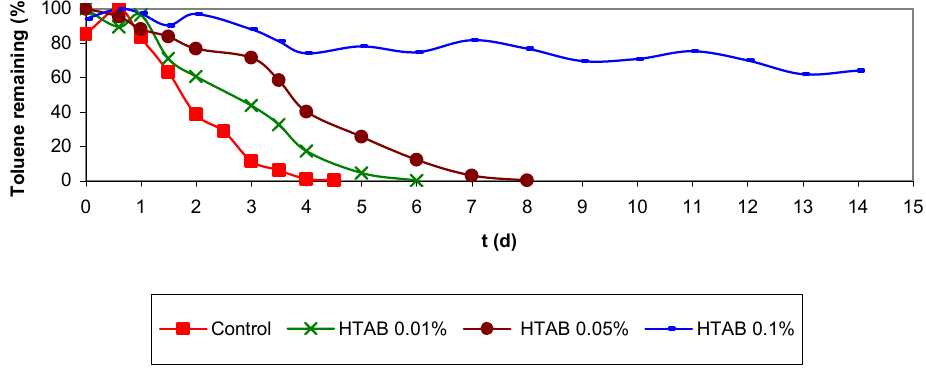
Figure 9. Batch assays with cationic detergent (HTAB) solutions and 11 µL toluene volume